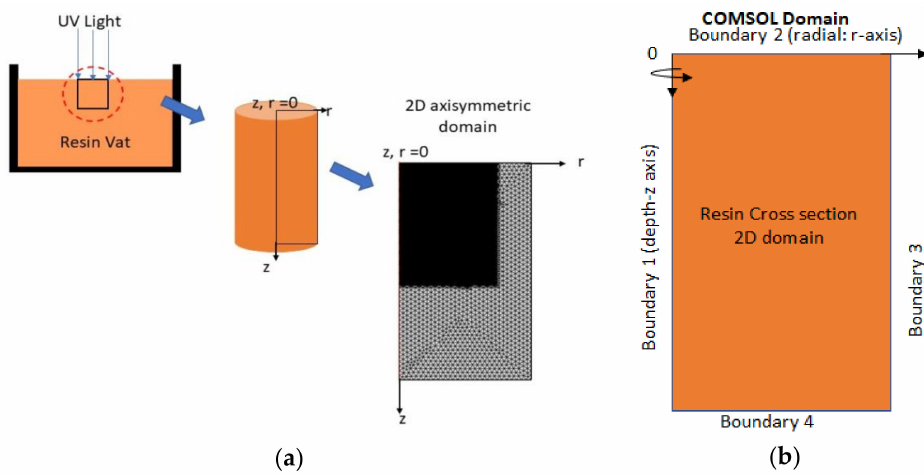
Figure 3. ( a ) 2D axisymmetric computational domain representation of UV exposed resin region in the vat. 2D axisymmetric domain consists of two domains that have different mesh sizes due to computational efficiency. ( b ) Computational domain with boundary conditions.